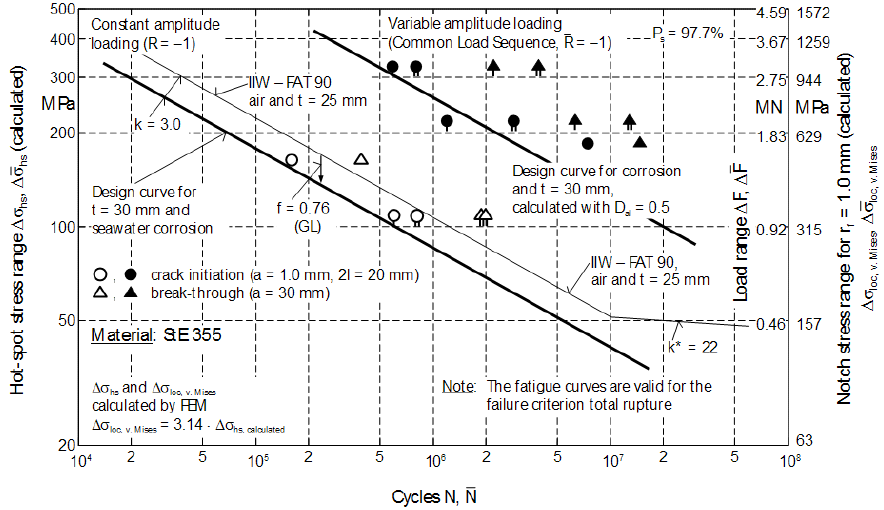
Figure 14: Application of the hot-spot concept for the evaluation of welded